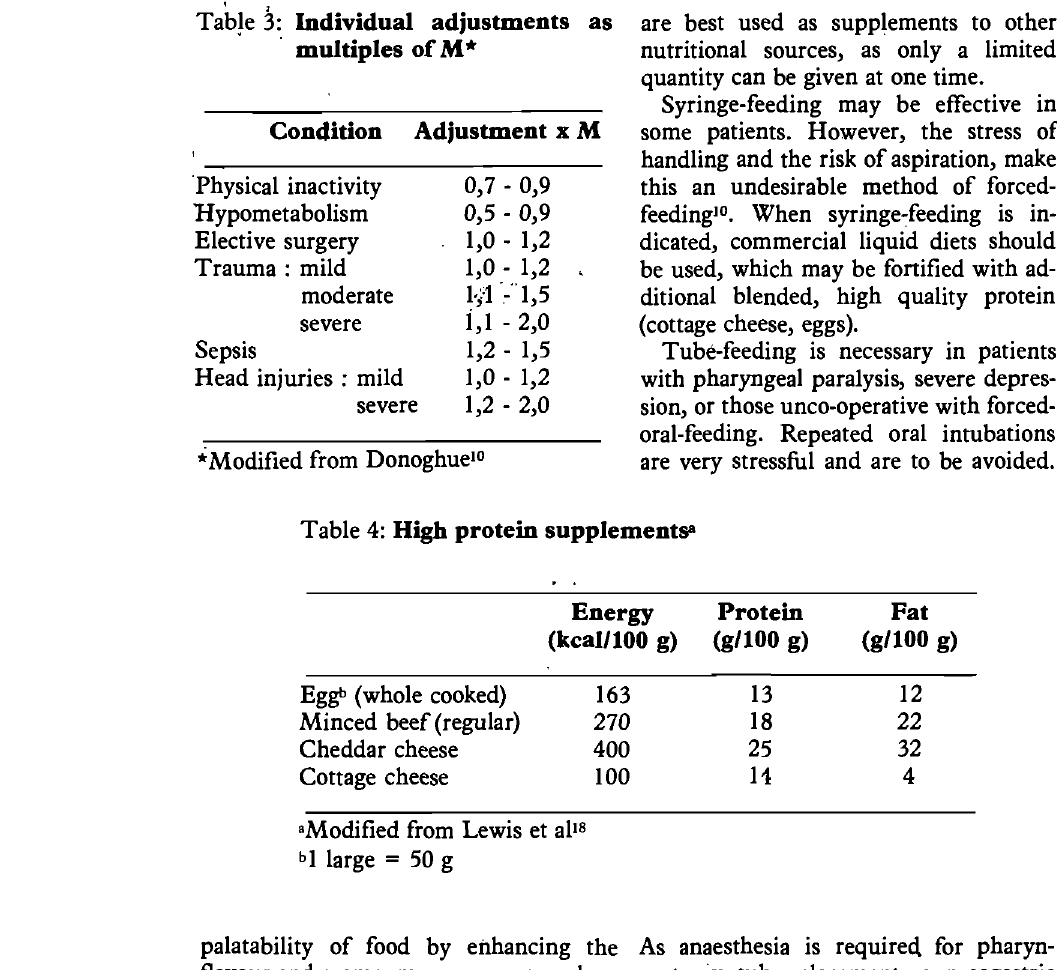
TabJe 3: Individual adjustments as